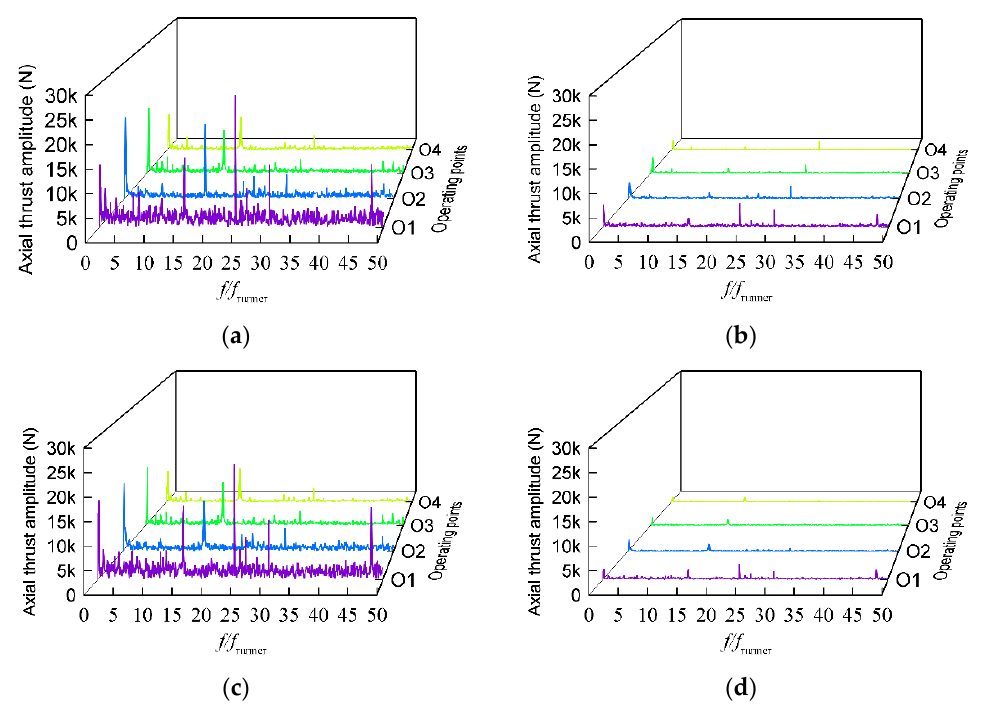
Figure 16. Spectral analysis of hydraulic axial thrust under the four different operating points for ( a ) total, ( b ) blade, ( c ) hub, and ( d ) shroud.